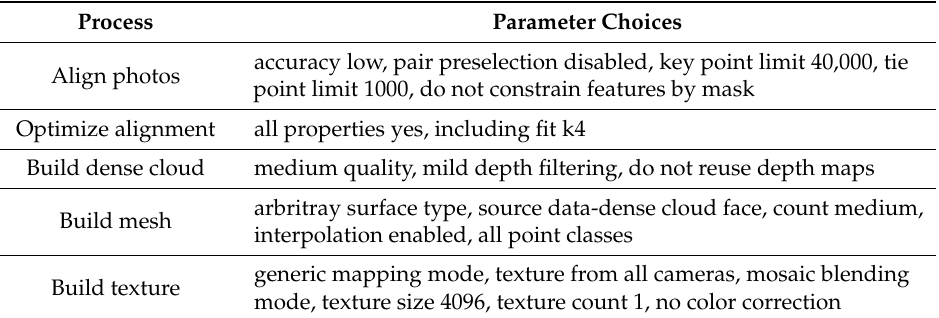
Table 1. Settings used for processing of patch-level models in Photoscan Professional (v1.1.6; Agisoft